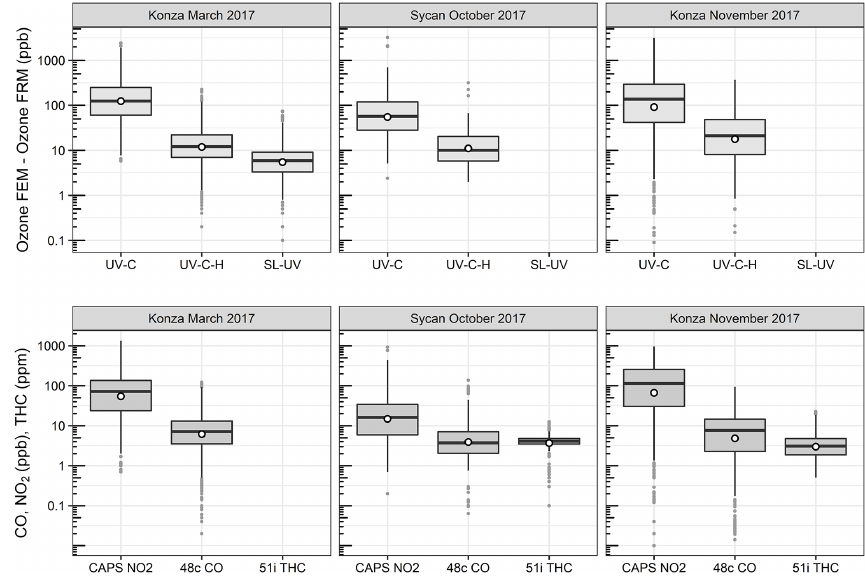
Figure 1. Ozone concentration differences between FEM instruments and the FRM instrument (FEM − FRM) and the measured NO 2 , CO, and total hydrocarbons (THCs) during the three 2017 wildfire deployments. All measurements included are within-smoke-only mea- surements, and show both the elevated smoke tracers (NO 2 , CO, THC) and the persistent elevation of the FEM O 3 measurements. The box-and-whisker plots indicate the 25th, 50th, and 75th quartiles, with the whiskers extending to 1.5 times the inner quartile range. The open dots indicate the mean values for each instrument within smoke.